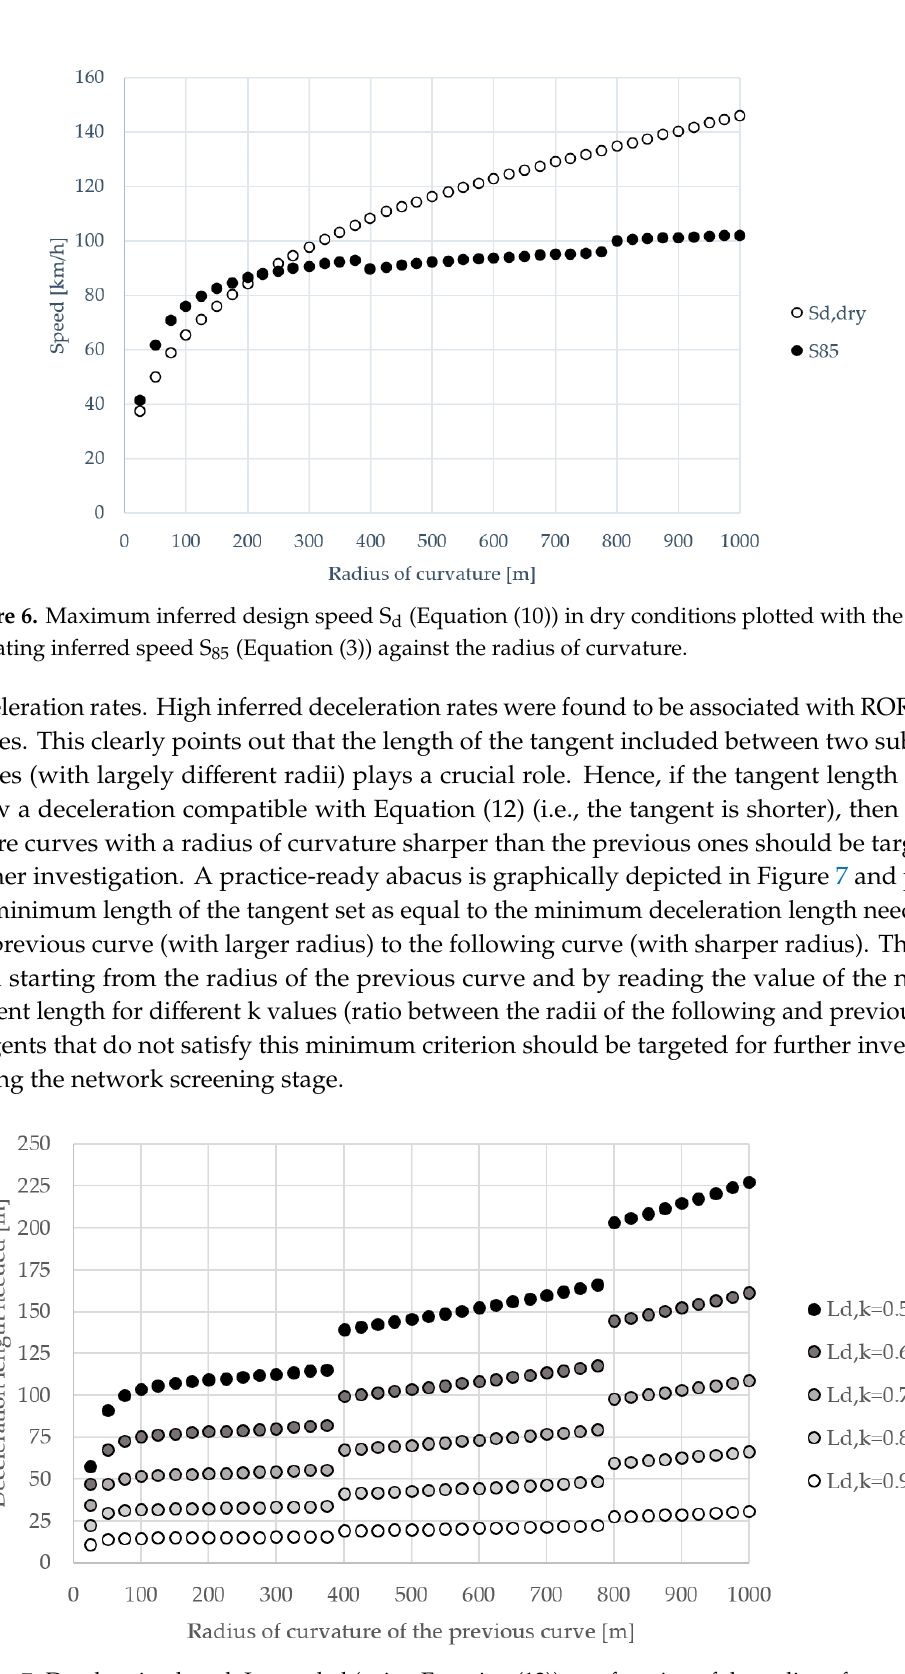
Figure 7. Deceleration length L d needed (using Equation (13)) as a function of the radius of curvature of the previous curve for different values of the k ratio (the following curve radius to the previous curve radius).